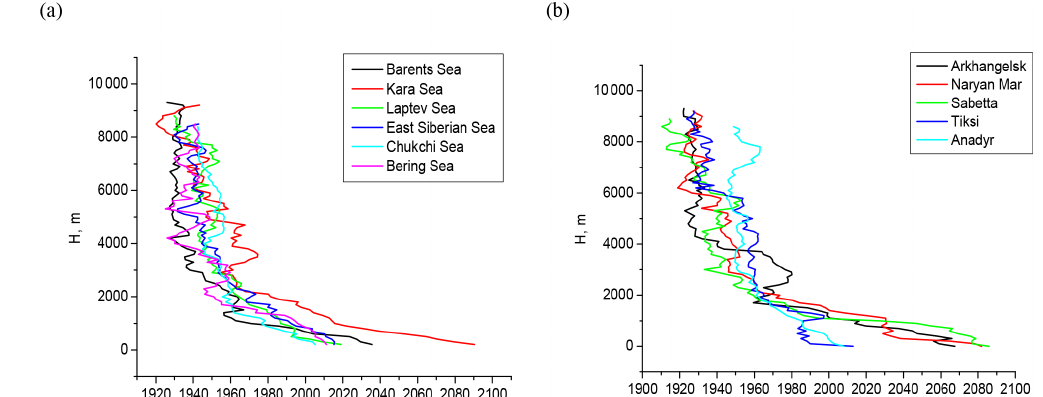
Figure 8. Vertical distribution of methane over sea (a) and coastal areas (b)